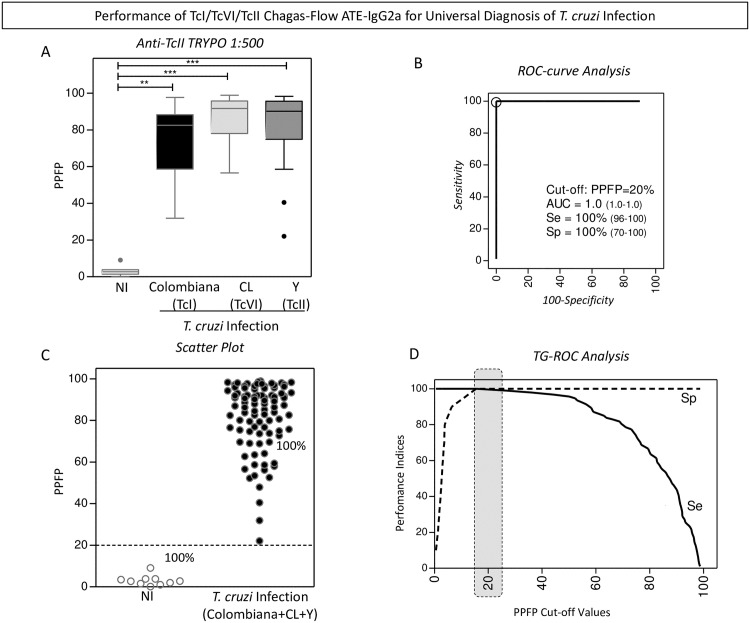
Performance of TcI/TcVI/TcII Chagas-Flow ATE-IgG2a for universal diagnosis of T. cruzi infection.(A) The anti-TcII TRYPO reactivity at 1:500, pre-selected as attributes pairs for universal T. cruzi infection diagnosis, were compared by Kruskal-Wallis followed by Dunn’s post test for multi-group comparisons and significant differences at *p <0.05, **p<0,001 and ***p<0,0001, highlighted by connecting lines. Data are expressed as median PPFP values for non-infected mice (white bar) and T. cruzi-infected hosts (TcI/Colombiana strain = black bar, TcVI/CL strain = light gray bar and TcII/Y strain = dark gray bar). The similarity amongst the anti-TcII TRYPO IgG2a reactivity at 1:500 observed for the three T. cruzi infected groups (Colombiana + CL + Y strains) allows the establishment of a single group referred to as T. cruzi infected hosts (n = 93) and the performance of the TcI/TcVI/TcII Chagas-Flow ATE-IgG2a in the universal diagnosis of T. cruzi infection carried out as compared to a group of non-infected mice (NI, n = 10). (B) ROC-curve analysis was applied to define the appropriated cut-off to discriminate the PPFP values from NI and T. cruzi-infected host (Colombiana + CL + Y strains). Additional performance indices were also calculated and provided in the figure, including the area under the curve (AUC), defined as global accuracy, the sensitivity (Se) and the specificity (Sp). (C) Representative scatter plot illustrates the ability of the selected set of attributes (“target-antigen/serum dilution/cut-off”) to discriminate the reactivity of the sera from non-infected (NI) and T. cruzi-infected hosts (Colombiana+CL+Y). The dotted line represented the cut-off of PPFP = 20% defined by the ROC-curve analysis. (D) TG-ROC analysis was also performed to confirm the cut-off selection at higher “Se” and “Sp”, highlighted by dark gray dotted frame.